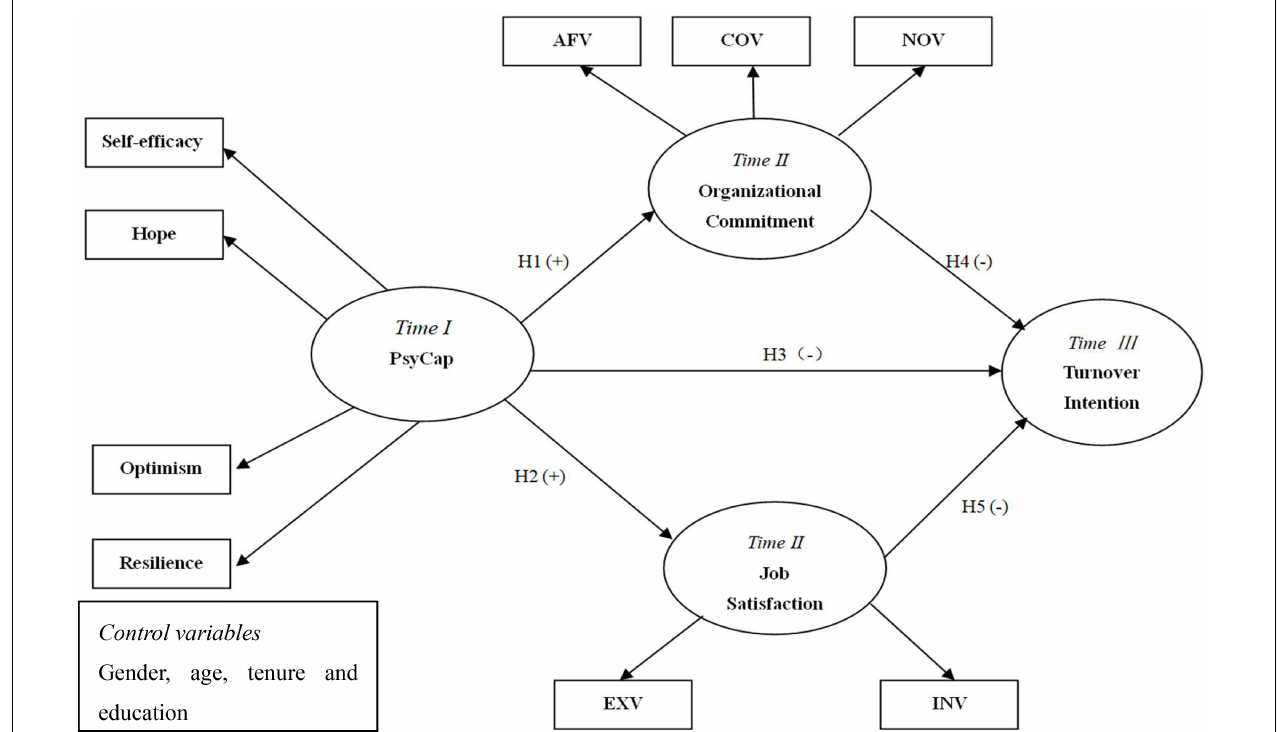
FIGURE 1 | Research